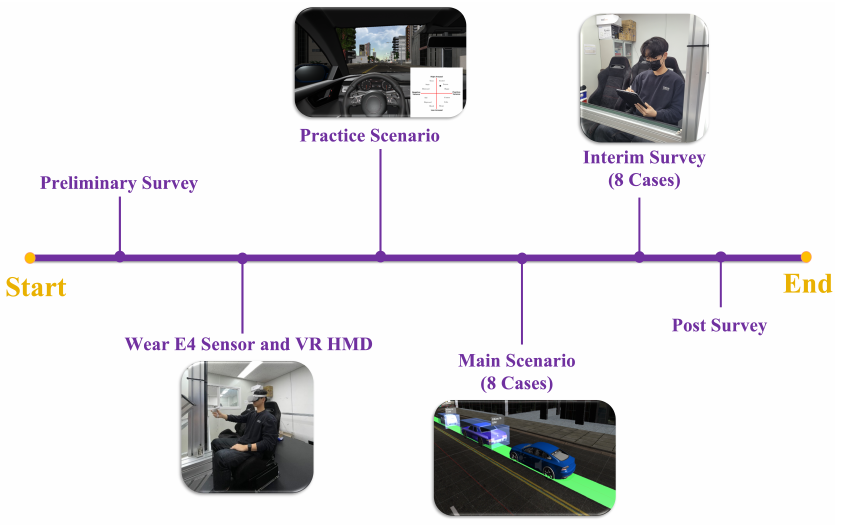
Figure 3. Timeline of the Experiment.